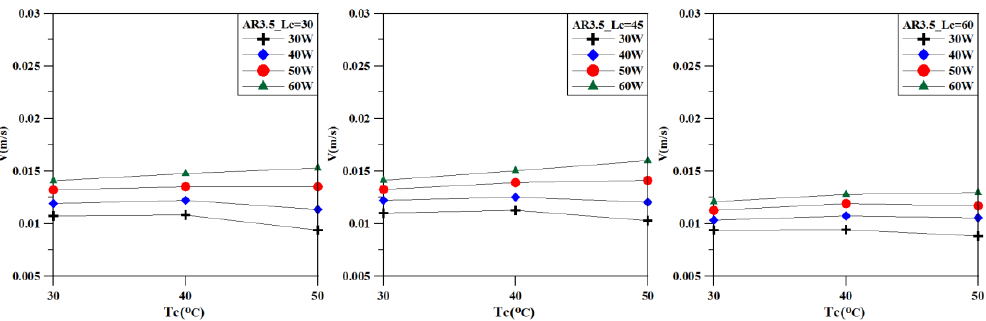
Figure 6. The relationship between average fluid velocity and temperatures of the cooling end Tc.